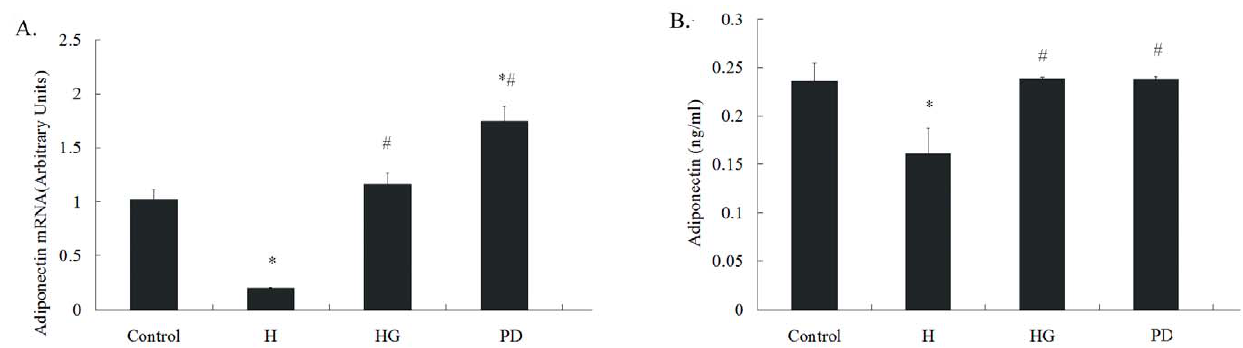
Figure 4. GTPs and selective inhibitor of erk1/2 alleviated high glucose-induced adiponectin decrease. One hundred fifty mg VAT were cultured in DMEM with high glucose (33 mmol/L) and cotreated with GTPs (4 m g/ml) for 48 hrs or pretreated with PD98059 for 1 hr. The supernatant of cell culture medium was collected for ELISA of secreted adiponectin. (A) The mRNA level of adiponectin, comparative Ct method with GADPH as reference was adopted. (B) The secreted adiponectin in the supernatant of culture medium is in ng/mL. High glucose incubation (H) down-regulated the mRNA expression and secretion of adiponectin, the effects could be attenuated by GTPs treatment (GH) or PD98059(PD). (* P , 0.05 vs. the control; # P , 0.05 vs. the HG group). Data is expressed as Mean 6 SEM (N=6).